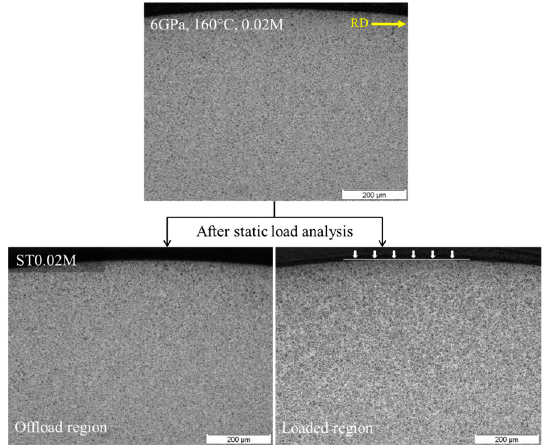
Figure 5. Circumferentially sliced micrograph acquired at 6 GPa, 160 °C after 0.02M rolling cycles. The static loaded and offload regions are also shown for ST0.02M.